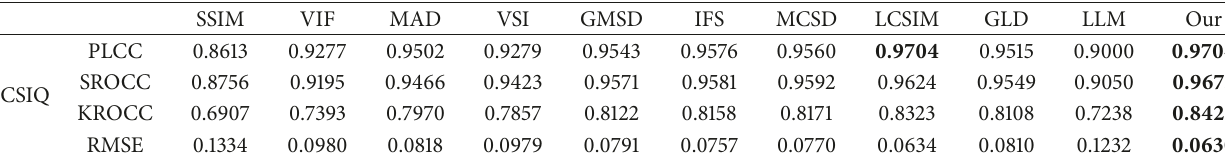
Table 5: Performance comparison on CSIQ database.